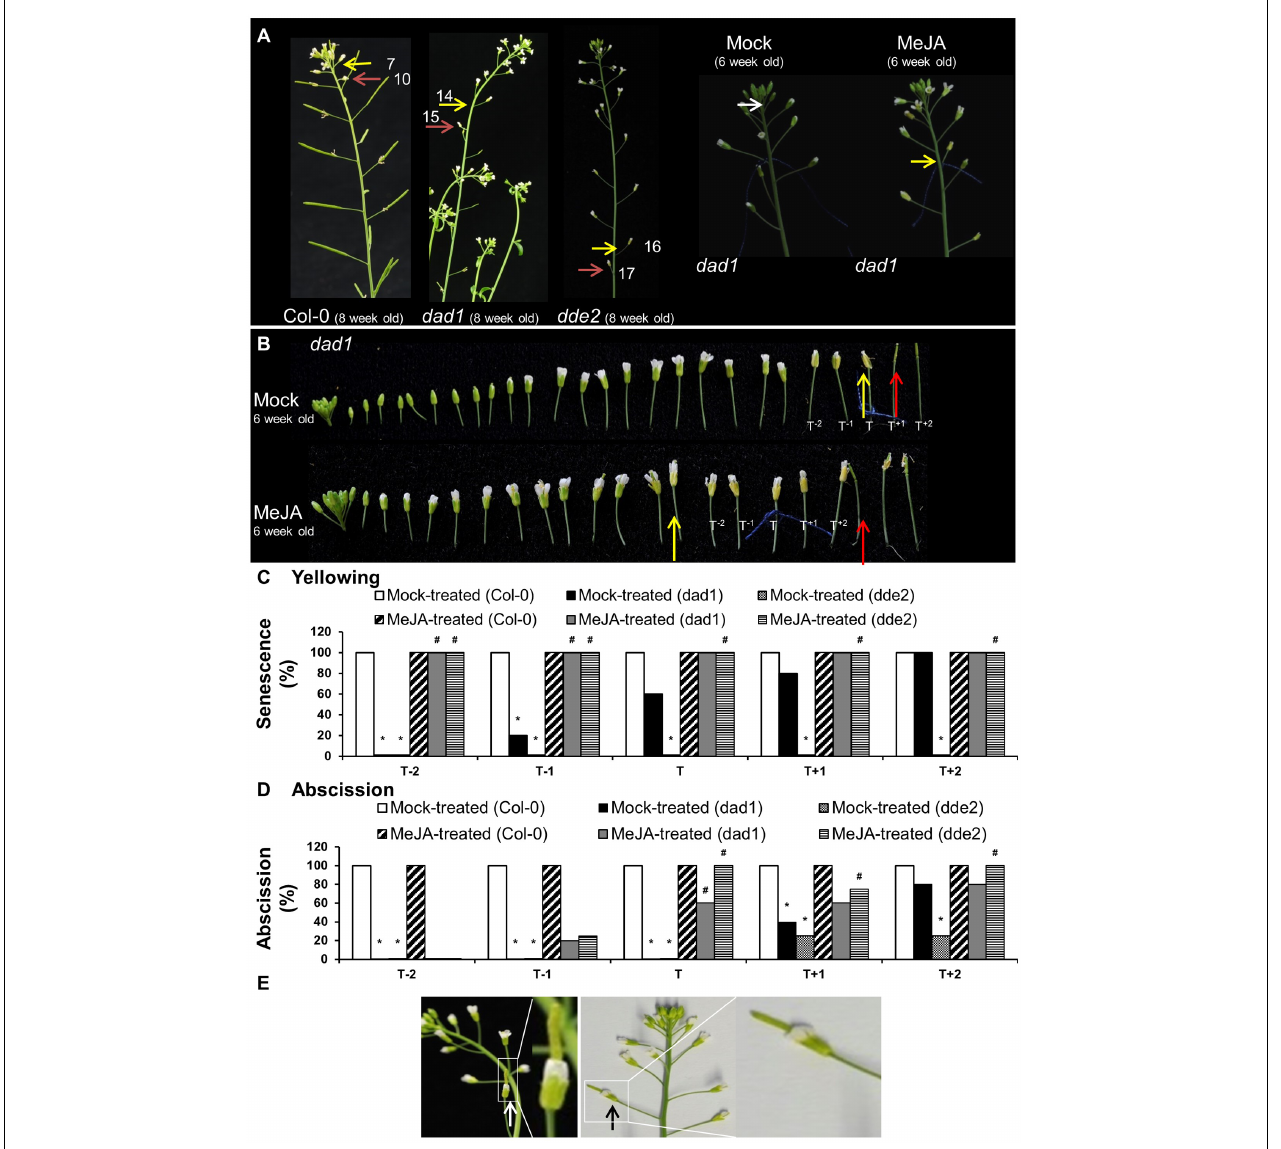
FIGURE 5 | Exogenous application of MeJA to Col-0, dad1 and dde2 flowers. (A) Col-0, dad1 and dde2 plants were grown for 8 weeks and photographed. Mock and MeJA treated dad1 plants were grown for 6 weeks and flower buds with visible white petals were tagged with a cotton thread at day 0 of MeJA or mock treatment. Plants were sprayed once a day with a mock solution or MeJA for 3 days. Inflorescences were photographed after 3 days of treatment. (B) Detached flowers of Mock- and MeJA-treated dad1 inflorescences. (C) Percentage sepal yellowing of Mock- and MeJA-treated Col-0, dad1 and dde2 flowers. (D) Percentage sepal abscission of Mock- and MeJA-treated Col-0, dad1 and dde2 flowers. (E) dad1 inflorescences showing hand-pollinated flowers developing into siliques (white and black arrows). The white arrow in (A) indicate a floral bud at stage 13 according to Alvarez-Buylla et al. (2010), yellow arrows indicate flowers with senesced sepals, red arrows indicate flowers with abscised sepals. T represents the tagged flower, T − 1 and T − 2 represent flowers younger than T, T + 1 and T + 2 represent flowers older than T. The numbers in (A) represent the flowering position according to the numbering system of Bleecker and Patterson, 1997. The photographs shown are representatives of four to six biological replicates. Sen, Senescence; Abs, Abscission, 0% datapoints are placed slightly above the X -axis. Statistical differences between mock treated wild type and mutants (indicated by ∗ ) and mock- and MeJA-treated mutant plants (indicated by # ) were calculated according to the Wilson score confidence limits for a percentage as calculated in Agresti and Coull (1998) (Supplementary Table S2).